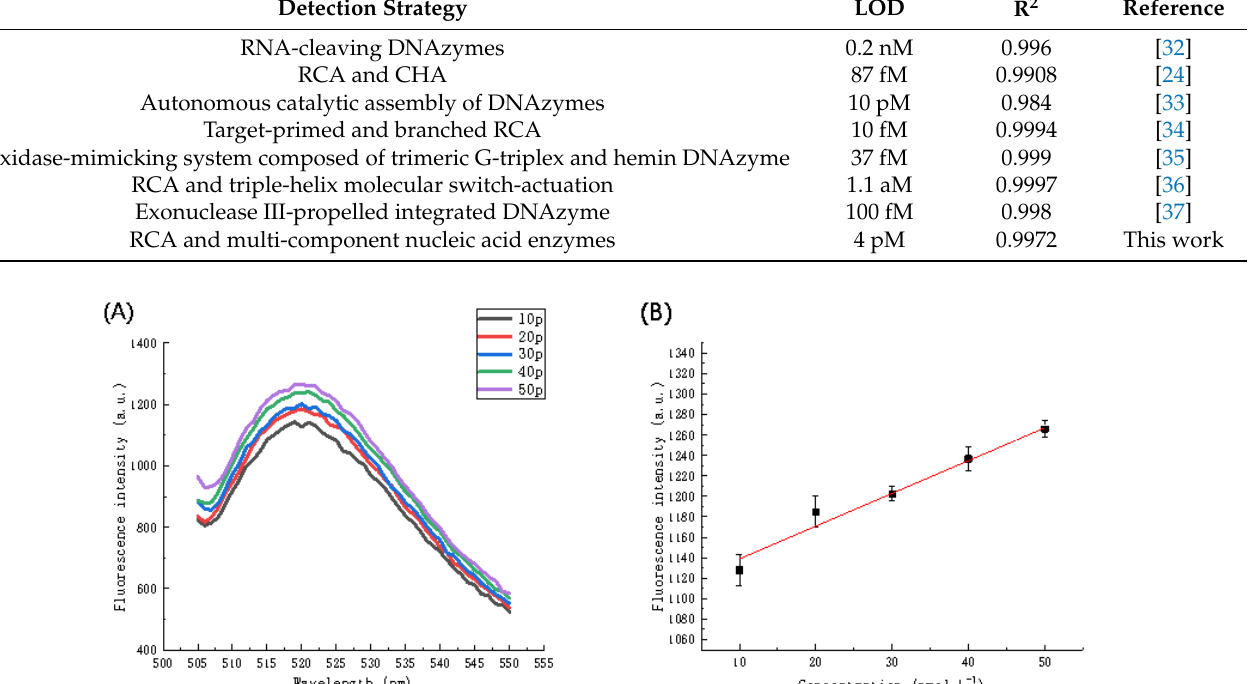
Figure 12. ( A ) Fluorescence spectra in the presence of different concentrations of miRNA (in serum). ( B ) Calibration curve of fluorescence intensity and miRNA concentration in serum. The error bars represent the standard deviation of three repeat experiments.